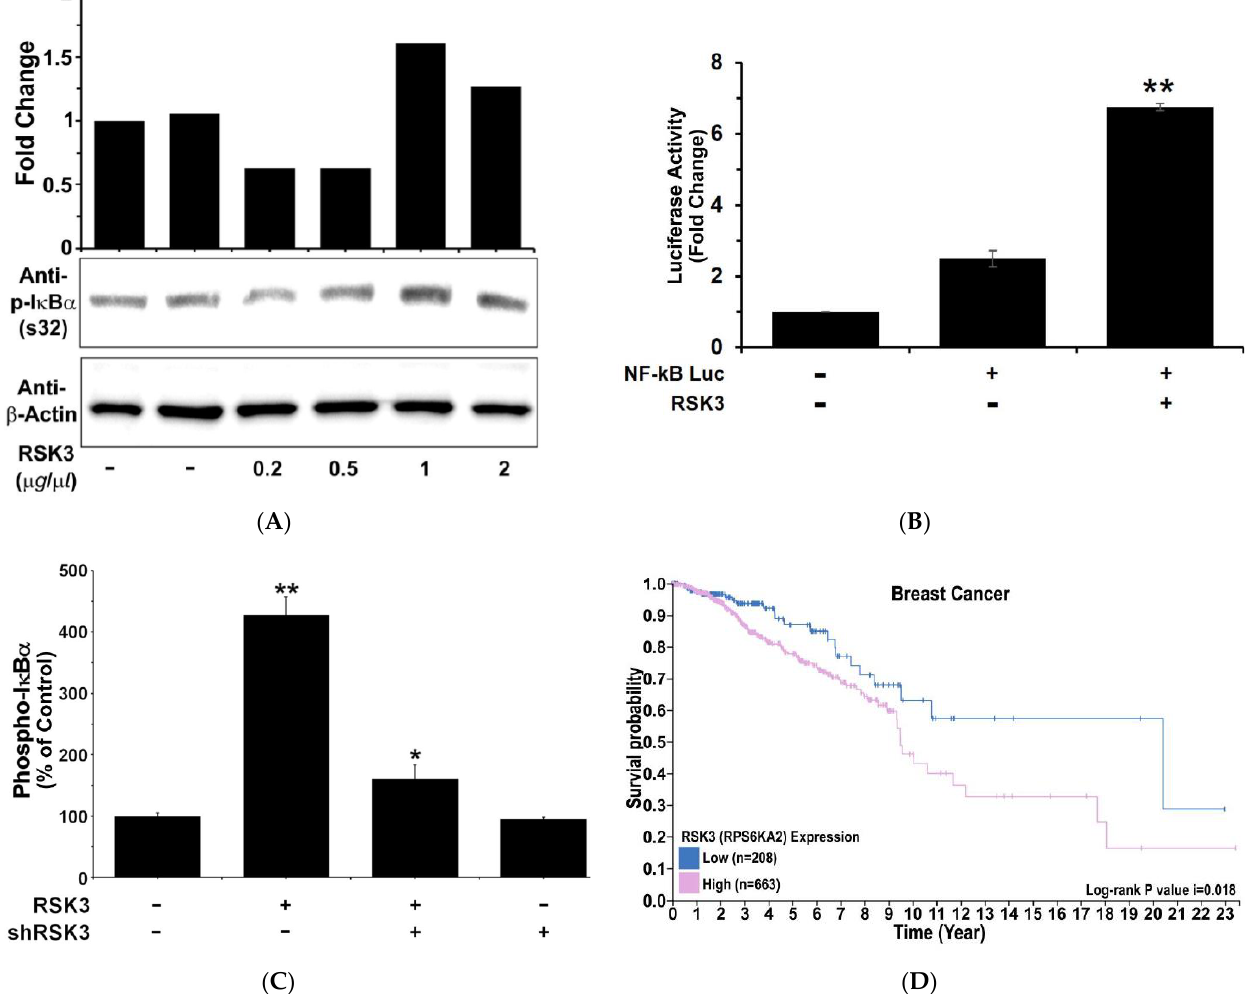
Figure 3. RSK3 activates NF- κ B via phosphorylation of I κ B α . ( A ) MDA-MB-231 cells were transfected with RSK3, and RSK-induced I κ B α phosphorylation was analyzed by Western blotting using a p-I κ B α (S32) antibody. Representative results from three experiments are shown. ( B ) NF- κ B luciferase activity increased with expression of RSK3. HEK293T cells were co-transfected with 0.5 µ g pGL3-NF- κ B-Luc, 0.5 µ g pcDNA3.1-RSK3, and 0.2 µ g pCMV- β -gal. Luciferase activity was normalized against β -galactosidase activity (** p < 0.01 vs. control). ( C ) I κ B α activation assay. HEK293T cells were inoculated onto a black 96-well plate. Cells were transfected with 100 ng of a RSK3 expression vector alone, the RSK vector and either a control or shRNA (AGGTCCTGAAGCGTCAAGGCTATGATGCG) targeting RSK3 or shRNA alone. I κ B α kinetic activity assays were performed (** p < 0.01 and * p < 0.05 vs. control). ( D ) Kaplan–Meier curve shows that breast cancer patients with low RSK3 expression ( n = 208) have a better prognosis than those with high RSK3 expression ( n = 663) (Log rank p -value I = 0.018). NF- κ B is the downstream target of I κ B α . RSK3 binds to I κ B α and increases I κ B α phosphorylation (Figure 1). Phosphorylated I κ B α is targeted for ubiquitination and sub- sequent degradation, and free NF- κ B is translocated to the nucleus from cytosol and activated. We performed a NF- κ B luciferase promoter–reporter assay using RSK3 treat- ment. Overexpressed RSK3 induced I κ B α phosphorylation via binding to I κ B α , and NF- κ